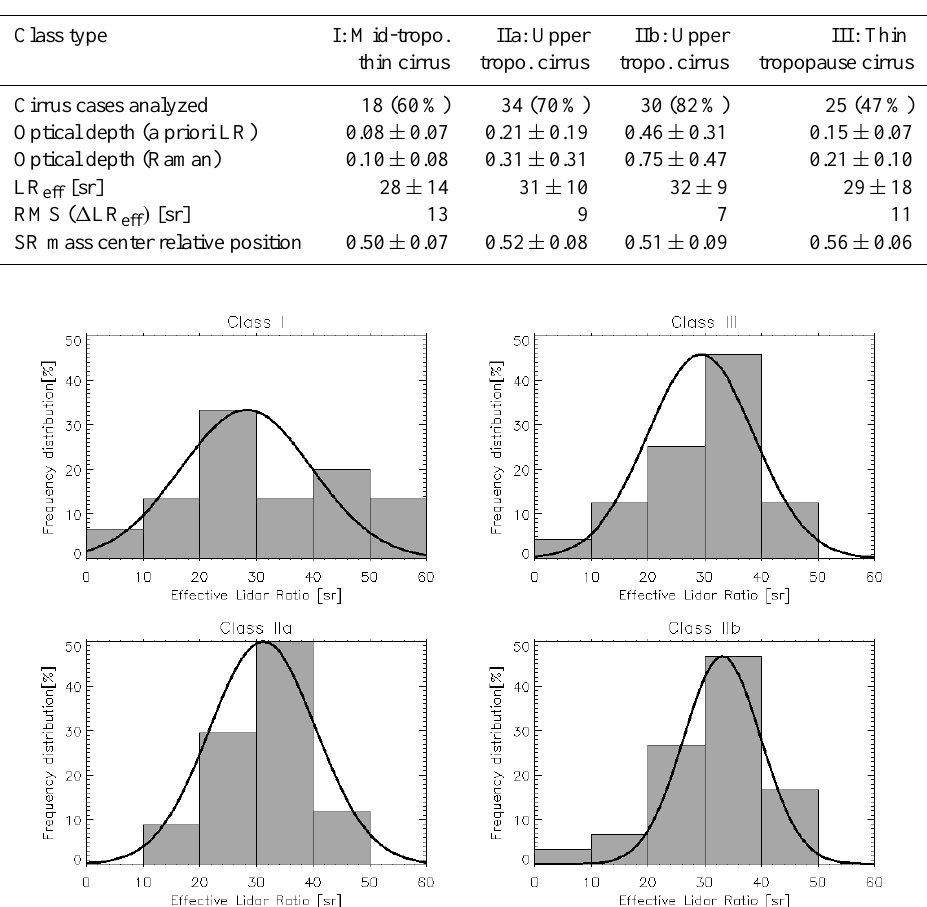
Table 4. Mean optical parameters for each cirrus class derived for a subsample of cirrus cases with 1τ Rm / τ Rm ≤ 30%. The fractions of the total lidar observations used for these results are given in parentheses.